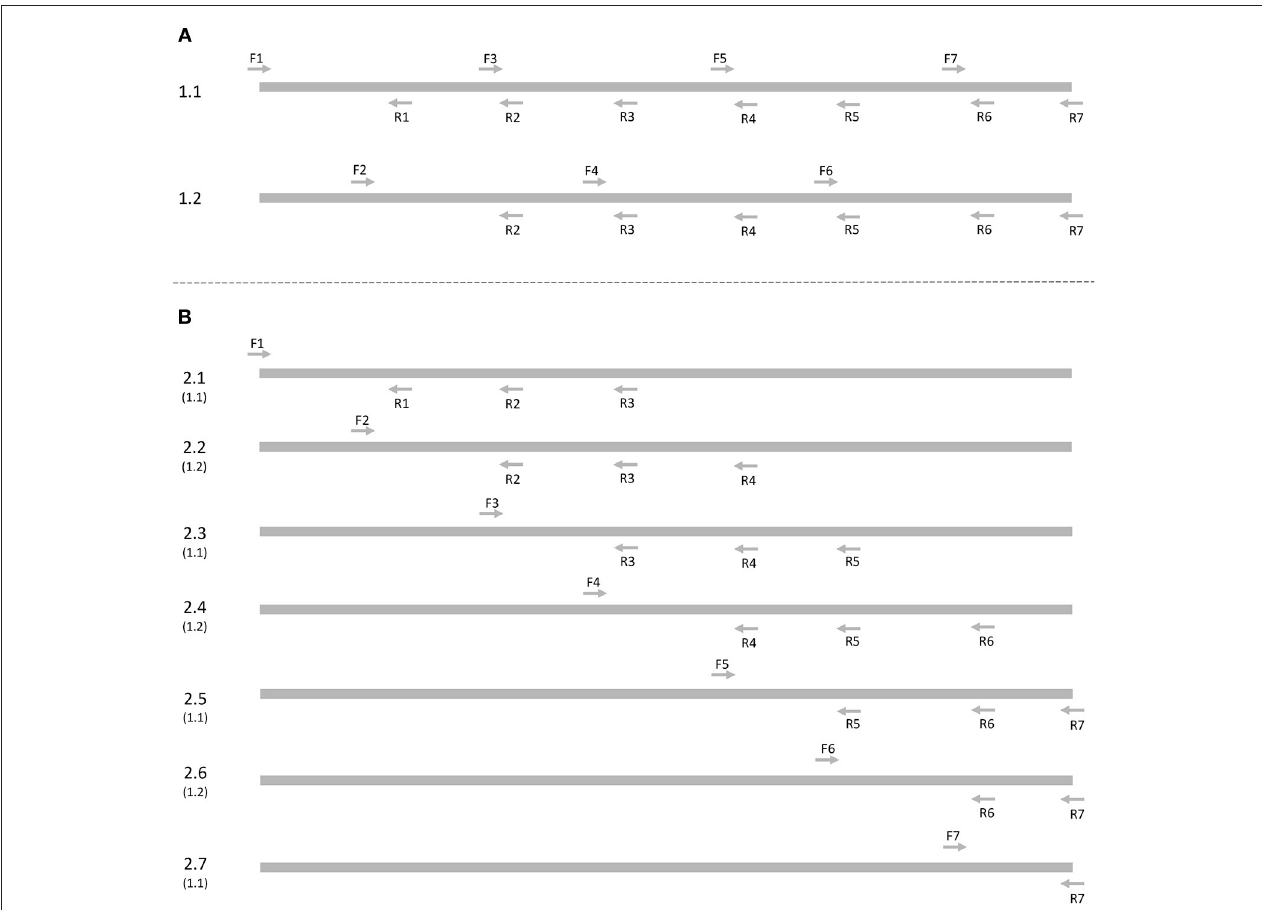
FIGURE 2 | Primer set up for PCR amplifications. (A) PCR round 1 with two separate reactions: 1.1 with odd-numbered forward primers and all reverse primers, 1.2 with even-numbered forward primers and the last six reverse primers. (B) PCR round 2 with seven separate PCR reactions using the PCR products from PCR round 1 as template: each forward primer is paired with the subsequent three reverse primers (two reverse primers in 2.6 and one reverse primer in 2.7).